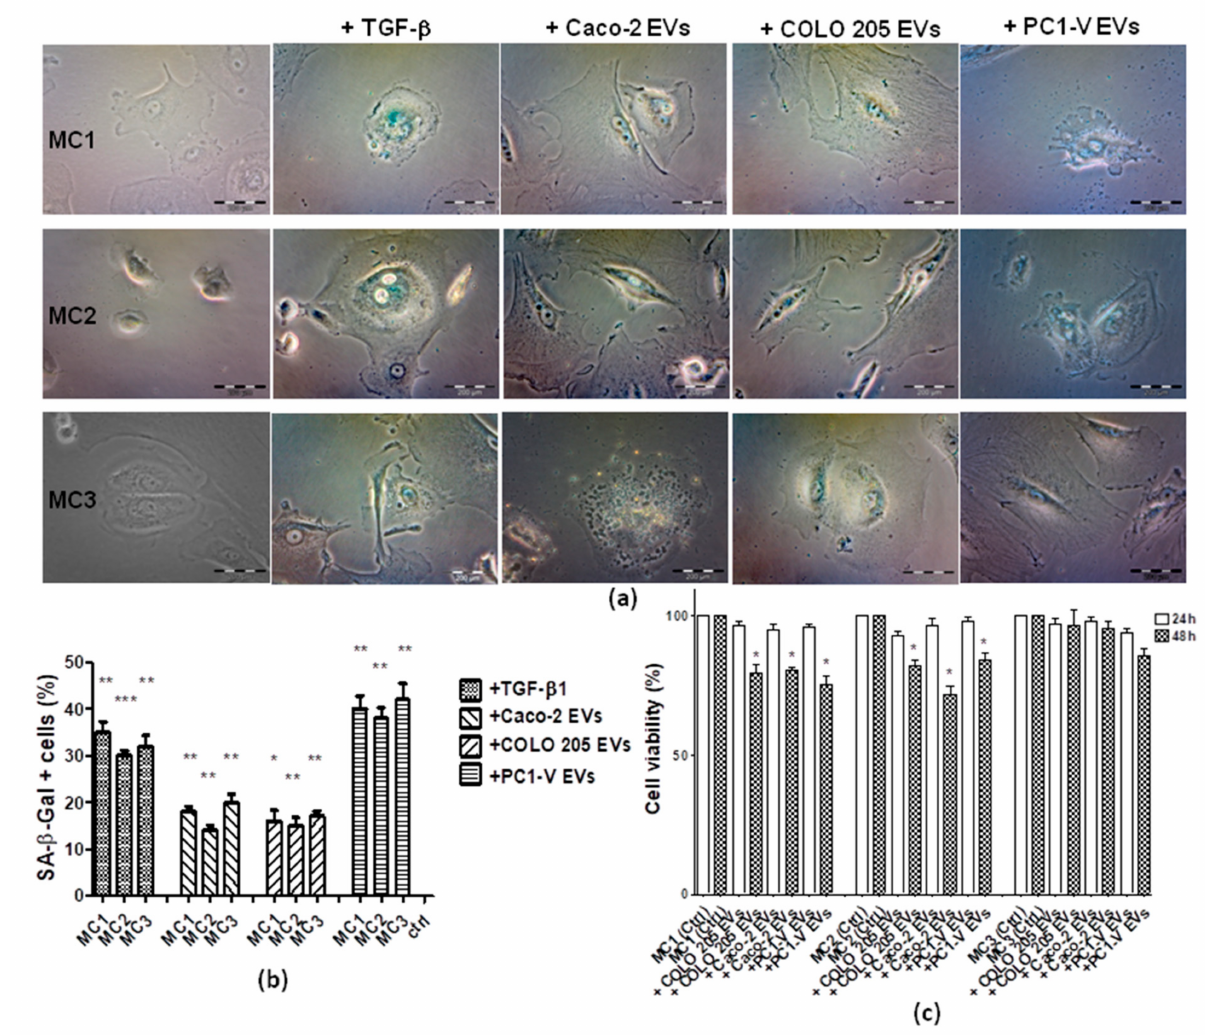
Figure 6. Senescent phenotype is induced by tumor EVs and TGF- β 1 in MC cell lines. ( a ) Representative images of optical microscopy showing blue color staining for SA- β -Gal in MC1-3 especially after treatment with PC1-V EVs and TGF- β 1. Treatment with COLO 205 EVs and Caco-2 EVs caused mainly abnormally shaped and apoptotic cells. ( b ) Histogram bars showing the percentage of SA- β -Gal positive cells. (*** p < 0.001, ** p < 0.01, * p < 0.05 vs. untreated cells) ( c ) Histogram bars showing the percentage of cell viability (* p < 0.05 vs. untreated